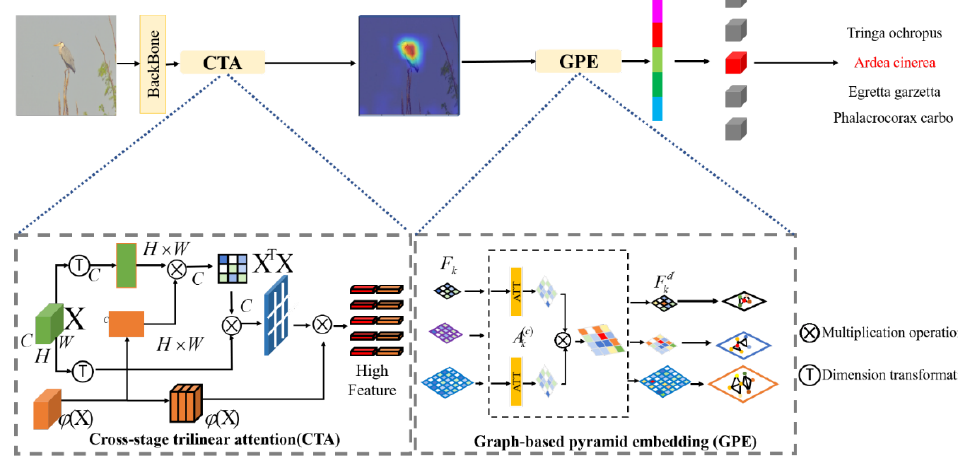
Figure 1. The GPA - Net framework based on a graph attention pyramid. We generate a library through the cross - stage attention module (CTA) and use feature maps of different levels to form an attention pyramid. Then, the pyramid layer is embedded into features by the graph method to form a graph attention pyramid network (GPE). Finally, multiple features are connected to obtain attention